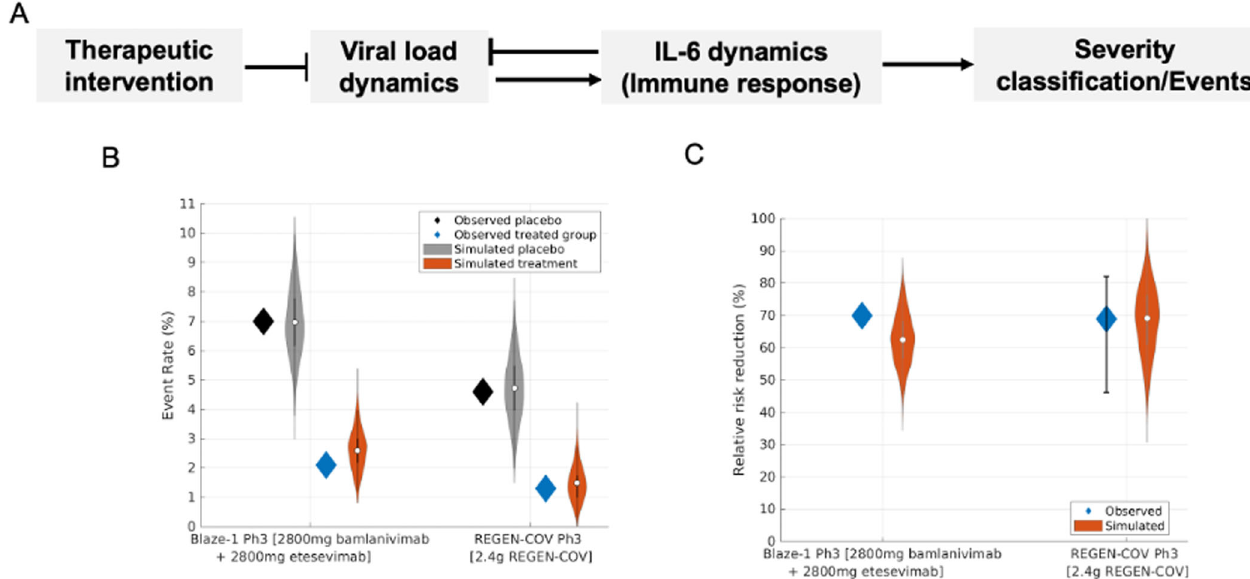
Fig. 5 The virtual population captures the relative risk reduction for the Blaze-1 Ph3 and REGEN-COV Ph3 placebo and treatment groups. A Work fl ow depicting interplay between viral load dynamics and plasma IL-6 levels, the key biomarker used to stratify COVID-19 severity. A therapeutic intervention that substantially decreases the viral load can decrease plasma IL-6 levels and thus, the rate of COVID-19-related events. B Event rates in the observed and simulated placebo and treated group respectively for the Blaze-1 Ph3 and 2.4 mg REGEN-COV Ph3 treatment arm. C Relative risk reduction in classi fi ed events in the simulated and observed Blaze-1 Ph3 and 2.4 mg REGEN-COV Ph3 treatment arms, respectively. Violin plots depict the 99% prediction interval of event rates and relative risk reduction, respectively from 1000 bootstrapped samples of the virtual population. Blaze-1 Ph3 virtual population, N = 502, REGEN-COV virtual population, N = 402. Data extracted from refs. 22,39